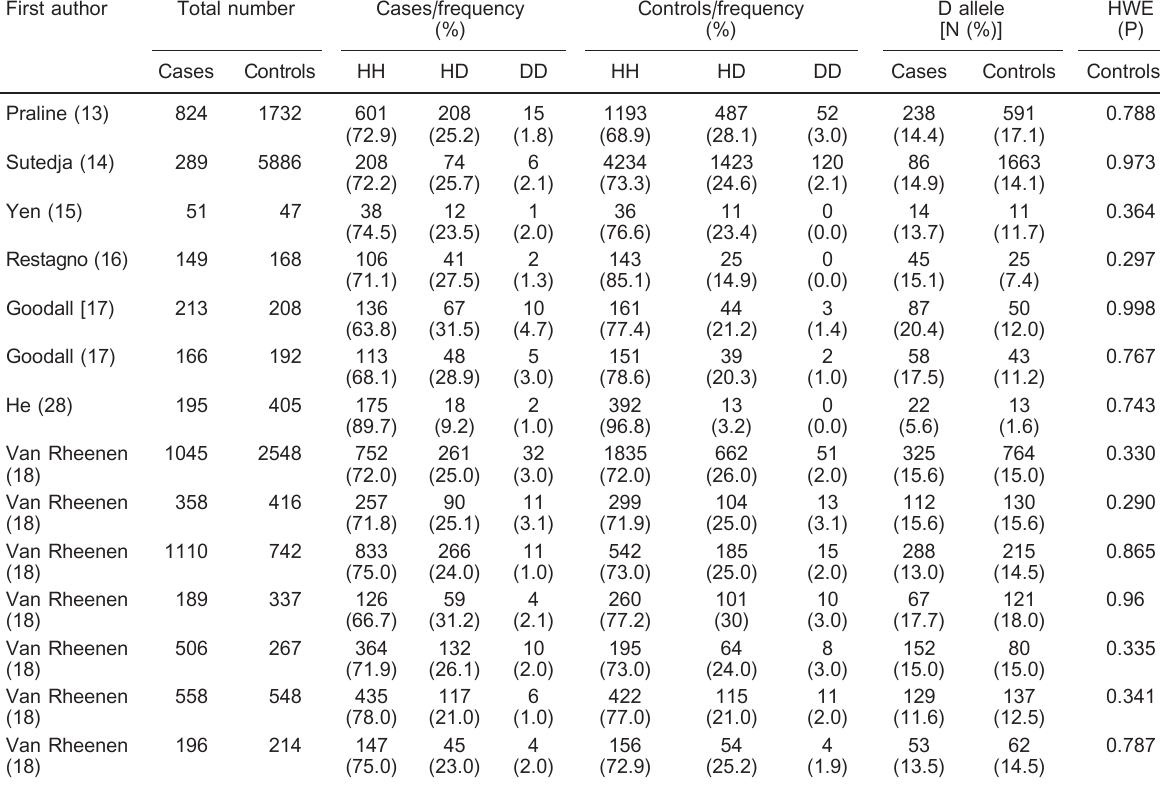
Table 2. Distribution of H63D (rs1799945) genotypes and allele frequencies among ALS cases and controls, and P values of HWE in controls.